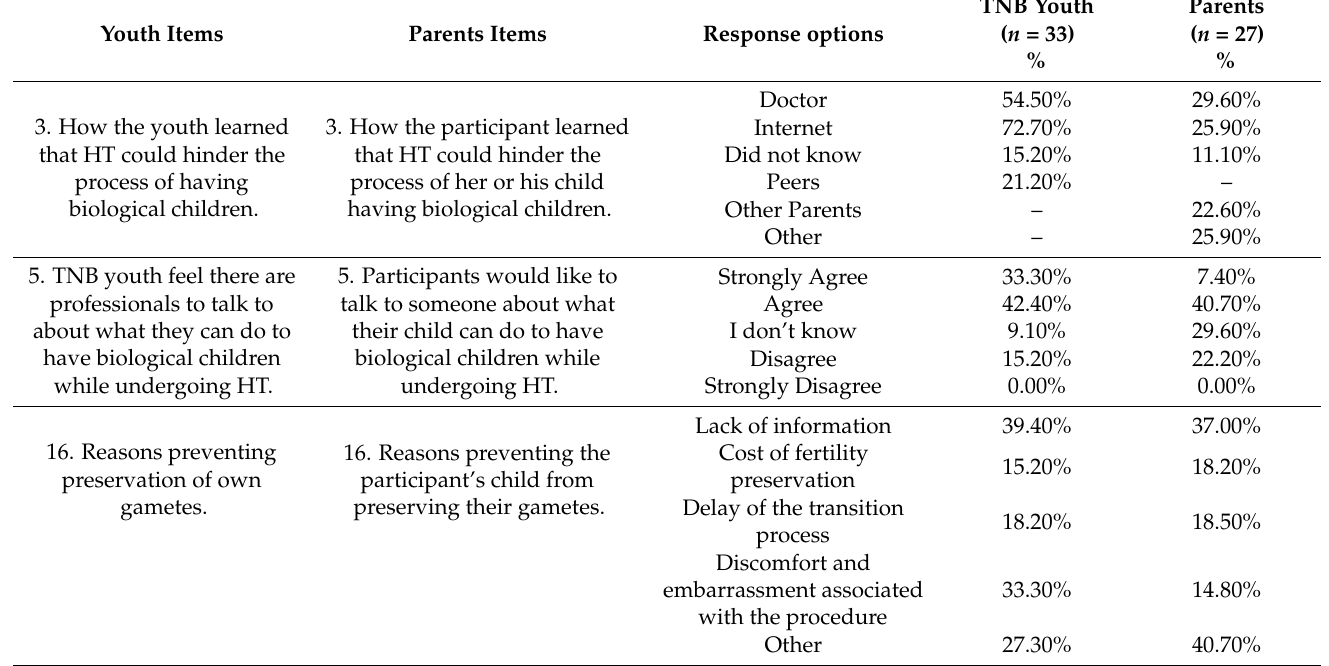
Table 3. Differences in Attitudes Towards Parenthood and Fertility Preservation between TNB Youth and Parents of TNB Youth (Items 3, 5, and